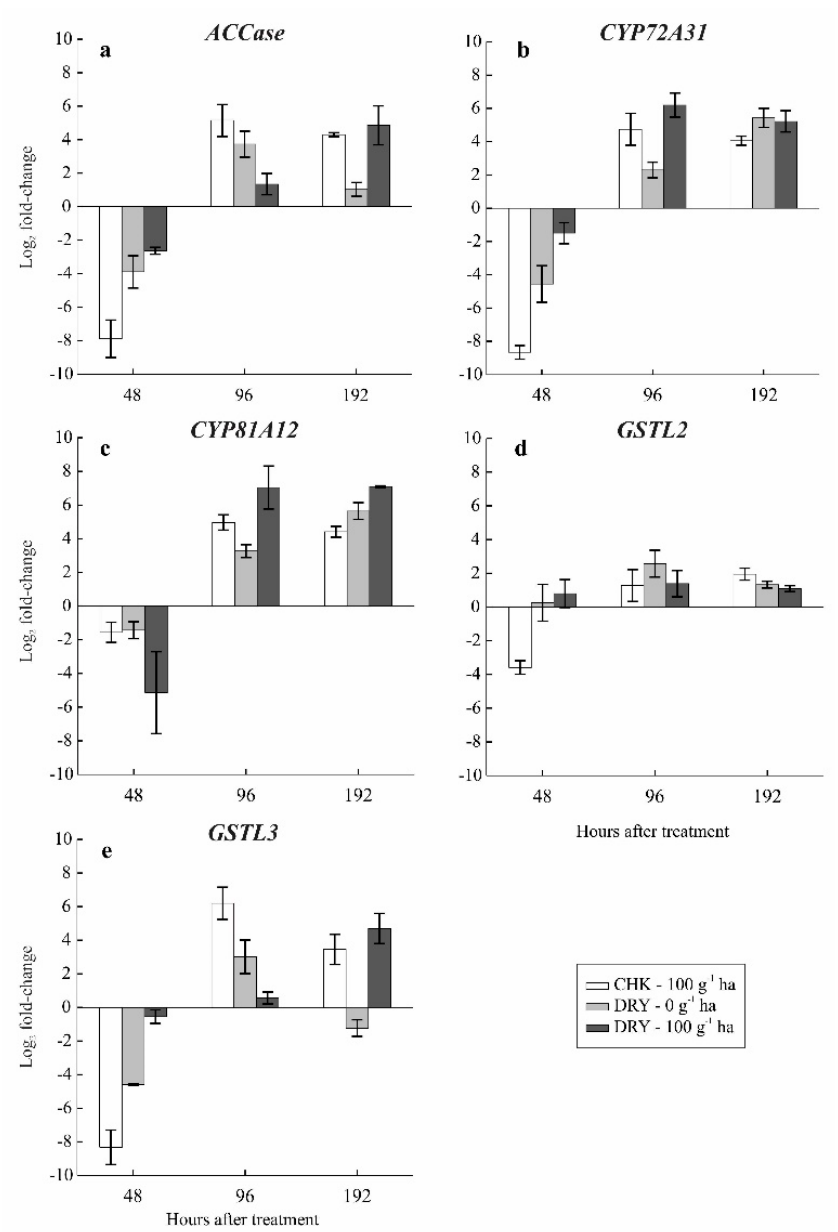
Figure 7. Relative expression levels in log 2 of ACCase ( a ), CYP72A31 ( b ), CYP81A12 ( c ), GSTL2 ( d ), and GSTL3 ( e ) gene in leaves of E. plana populations CHK-no stress–with 100 g ha − 1 of quizalofop (CHK-no stress-100 g ha − 1 —black bars), DRY–without herbicide (DRY-drought-0 g ha − 1 —dark gray bars) and DRY–100 g ha − 1 of quizalofop (DRY-drought-100 g ha − 1 —light gray bars) at 48, 96, and 192 h after application of herbicide. Error bars represent 95% confidence intervals. CYP81A12 gene belongs to the CYP81A subfamily of the P 450 enzyme [33]. At 48 HAA, CYP81A12 was downregulated in all populations (Figure 7c). CYP81A12 expression